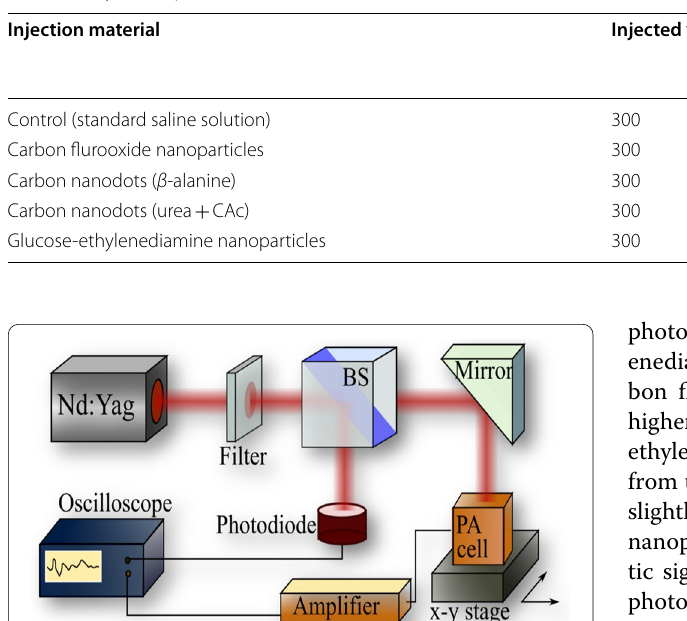
Table 1 Injection protocols